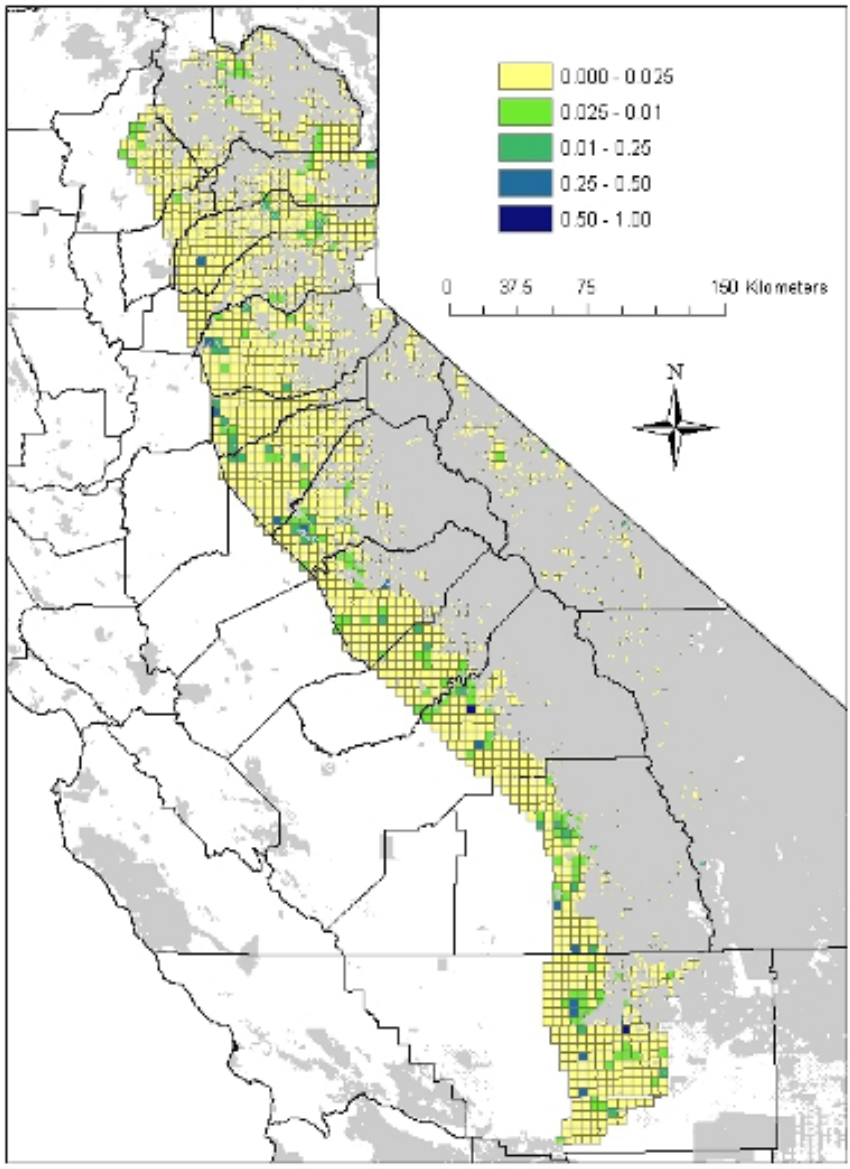
Fig. 6. Site marginal utility as a hotspot of rare, threatened, or endangered species. Highest-scoring sites are dark blue. County boundaries are drawn, and existing public and private reserved lands are shown as a gray